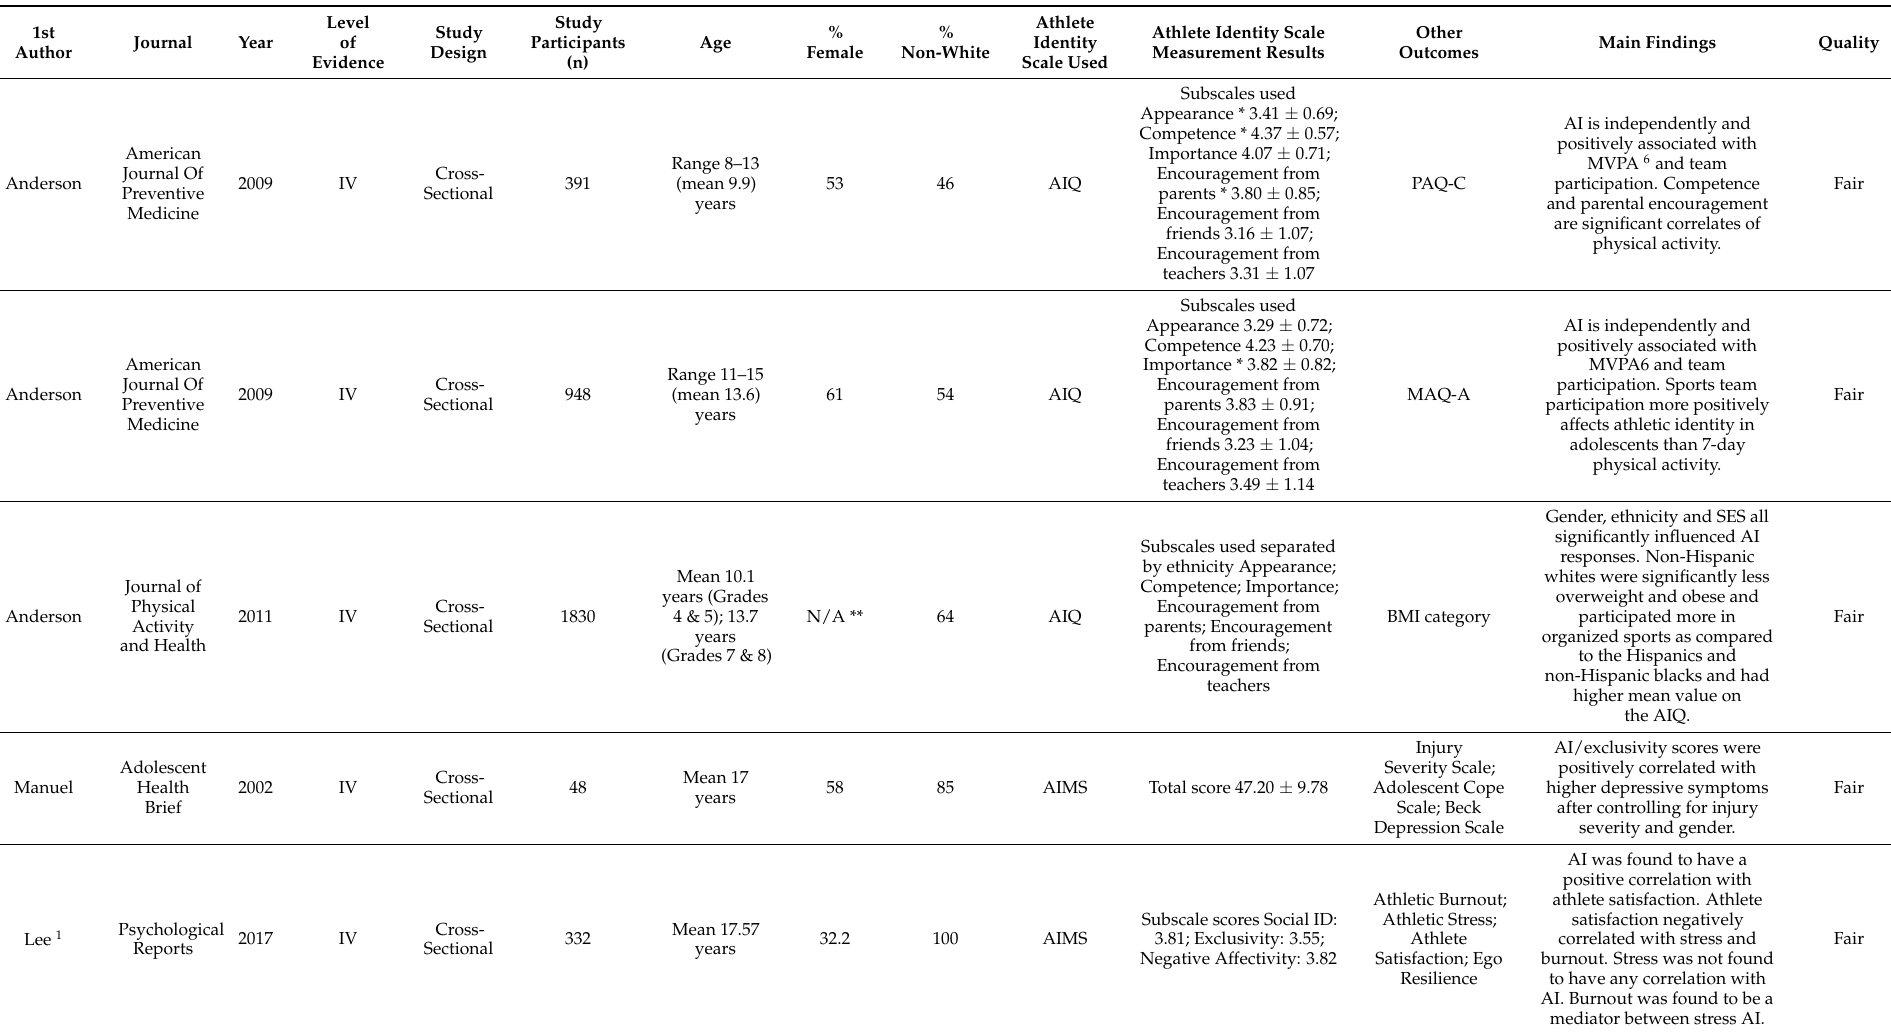
Table 1. Characteristics, Data Extraction from